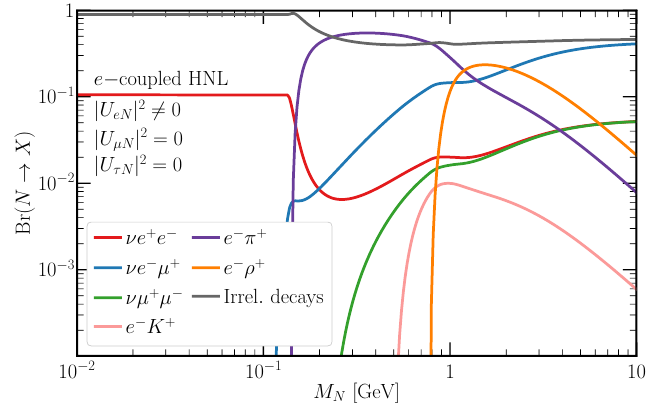
Figure 21 . The branching ratio of an electron-coupled HNL N into di(cid:11)erent (cid:12)nal states as a function of its mass M N . The grey curve is a collection of decays considered to be irrelevant, as described in the